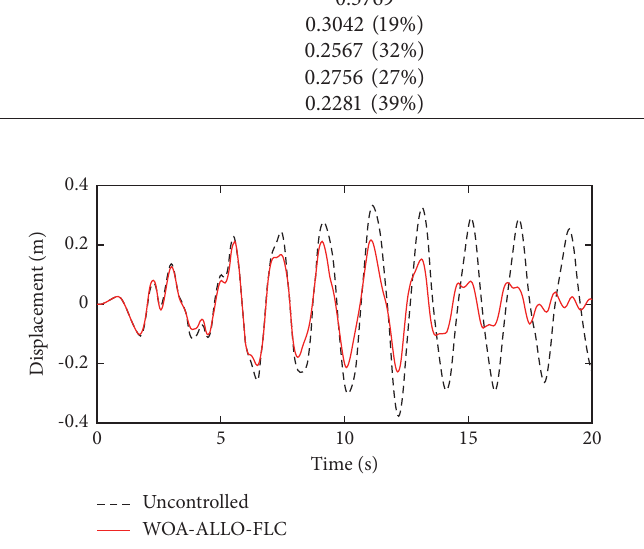
Figure 9: The top floor displacement response of Building 1.